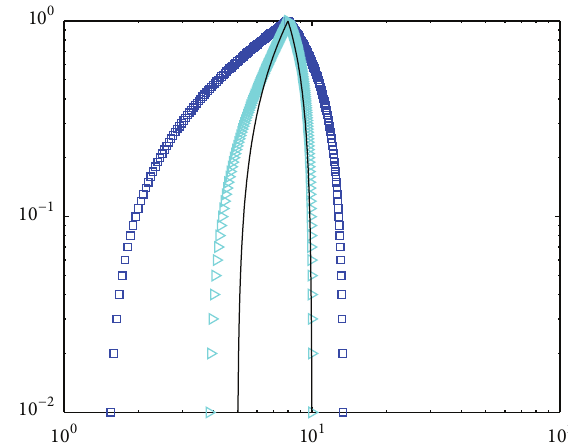
̃𝑏 (−) and the value of the first row for ̃𝑥 −,𝑙,𝑢 1